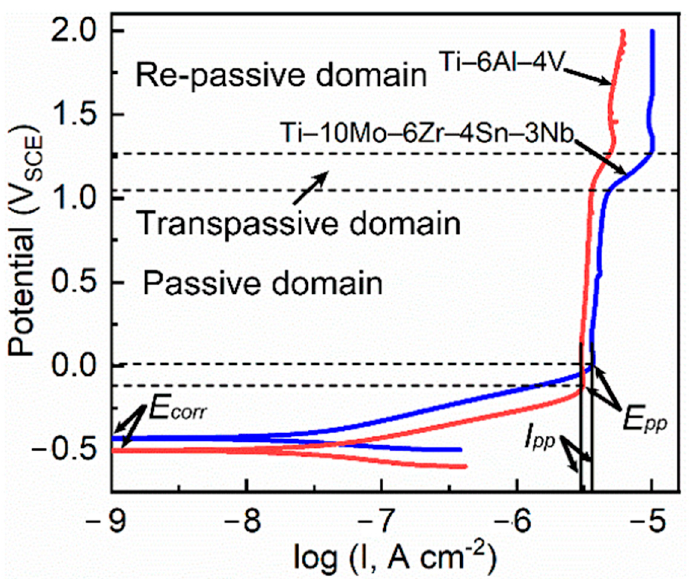
Figure 4. Potentiodynamic polarization curves of Ti–10Mo–6Zr–4Sn–3Nb and Ti–6Al–4V in Hank’s Fig. 4 solutions at 37 ◦ C. Table 2. Fitting results of potentiodynamic polarization curves of Ti–10Mo–6Zr–4Sn–3Nb and Ti– 6Al–4V in Hank’s solutions at 37 ◦ C. E corr is the corrosion potential; I corr is the corrosion current density; E pp is the passivation potential, I pp is the passive current